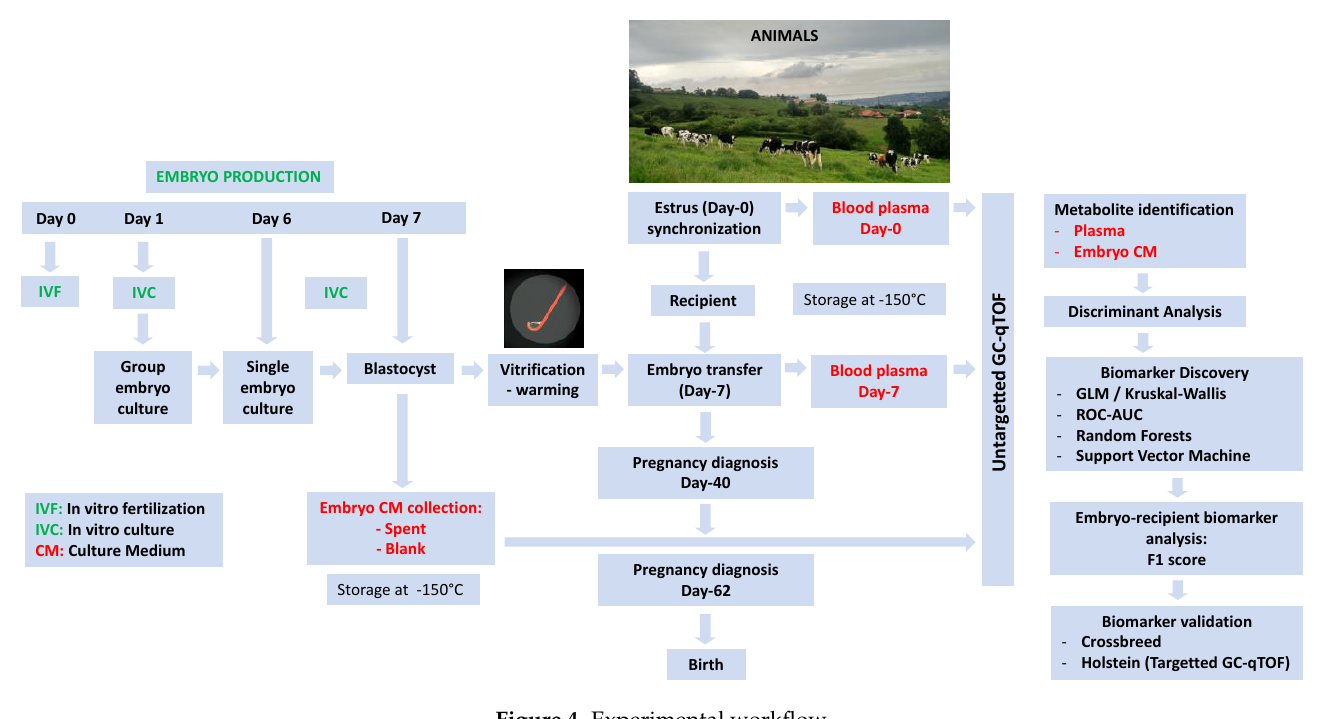
Figure 4. Experimental workflow.